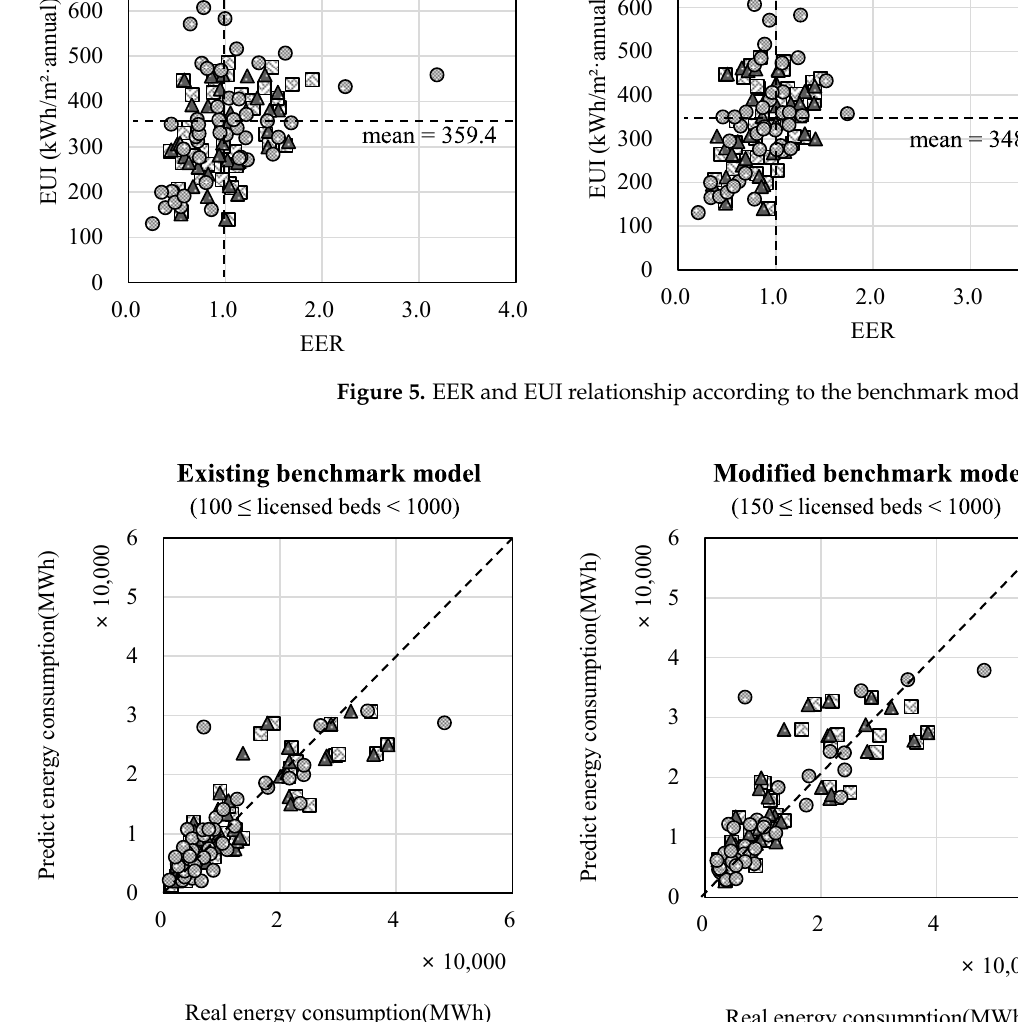
Figure 5. EER and EUI relationship according to the benchmark model.